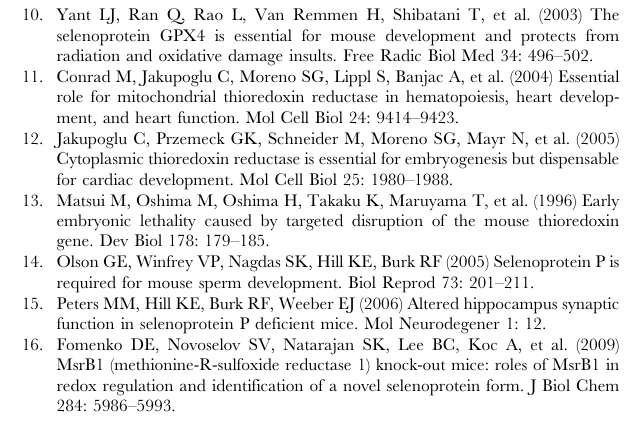
Figure S32 SECIS in SPS2a and SPSb. Multiple sequence alignment of opossum SPS2a and SPS2b, platypus SPS2a, and human SPS2b SECIS elements. Critical portions are marked in red. Figure S33 Multiple sequence alignment of SelW and SelV 3 9 -UTRs. Critical portions of the SECIS elements are marked in red. The last nucleotide of exon 5 is marked in black. Figure S34 Phylogenetic tree of SelW1, SelW2 and SelV proteins. ML phylogenetic tree of SelW1, SelW2 and SelV protein sequences computed using the WAG substitution model. The branch support for each node (computed as described in the methods) is shown in red. The bar at the bottom left shows the scale in substitutions per position. The Rdx12 gene was found in all tetrapodes but only frog, mouse and human were included in the phylogenetic tree. In contrast all SelW2 detected were included: this gene is missing in all tetrapodes apart from frog. SelW1 is missing from bony fishes apart from zebrafish. SelV was detected in all placentals except gorilla but only rat, cow and human were included. Note that while the SelV-SelW1 duplica- tion is clear and well supported, the rest of the tree is more confused. Nonetheless SelW2c, SelW2b and Rdx12 appear to have been generated by independent duplications. Figure S35 Multiple sequence alignment of TGR, zebra- fish TR1, and GRx-containing TR1. Residues are marked as in Figure S1. Note positions where zebrafish TR1 and TGR match, but are different than GRx-containing TR1 (i.e., positions 43, 142, 143, 149, 150, 324, etc.). Figure S36 Multiple sequence alignment of extended Dio2 sequences. The last residue of each exon is marked in black and the Sec residues in red. The second Sec, residue 269, is the stop codon or potential second Sec. Figure S37 Multiple sequence alignment of SelI and its sequence homologs. Homologs are labeled with the annotated name. Some sequences not annotated as CHPT1 or CEPT1 were also included, as they contain the same domain. Important residues in the active sites are marked in red. The last residue of each side of all predicted transmembrane regions are marked in green. Selenocysteines are marked in red. The cysteines emerged